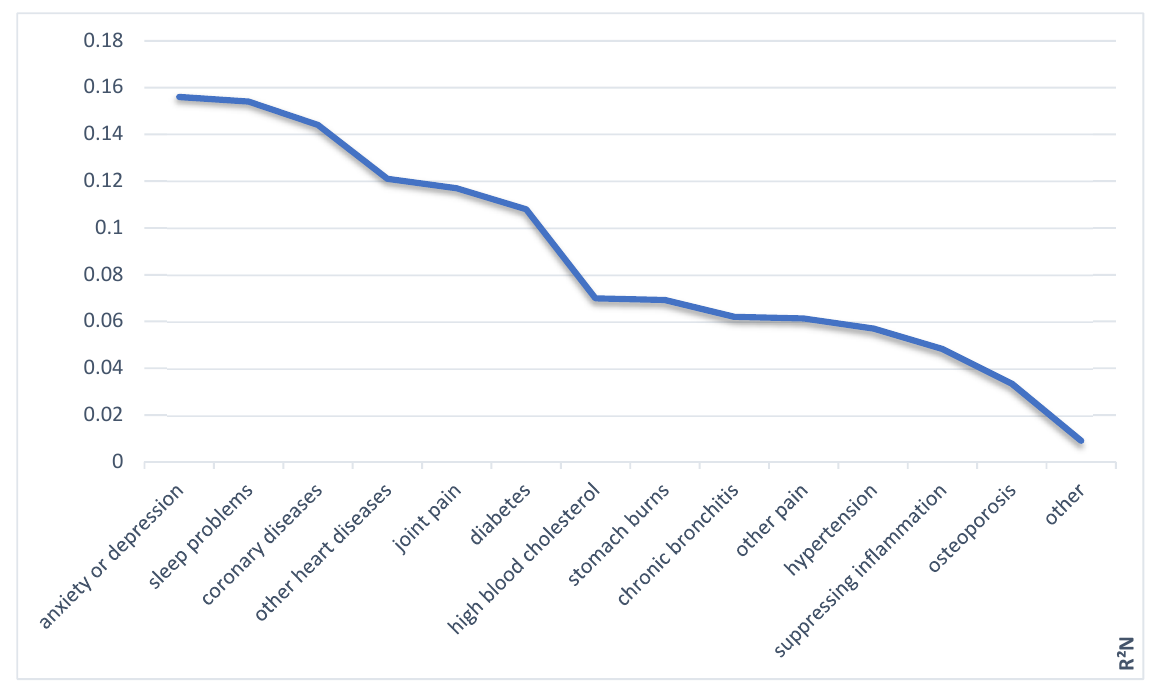
Figure 3. Explained variance (R²N) of self-reported medication use by memory, depression, and polypharmacy in corre- sponding binominal logistic regressions.